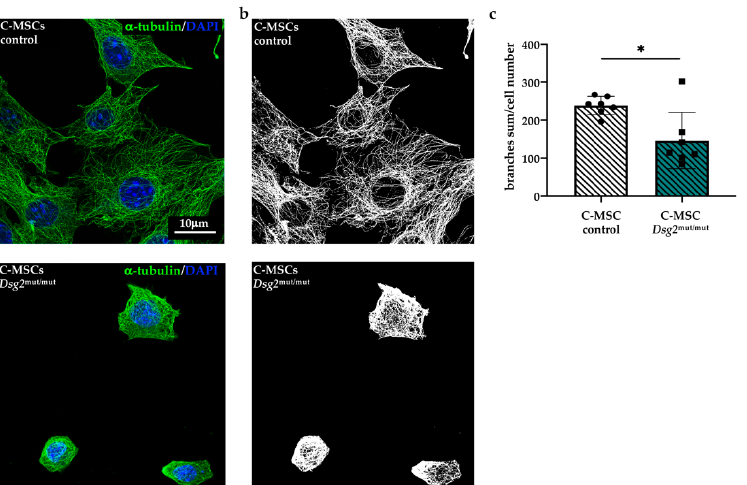
Figure 4. AC-linked Dsg2 variant affects microtubule organization in cardiac mesenchymal stromal cells. ( a ) Super-resolution confocal IF analysis of cultured C-MSCs isolated from control or Dsg2 mut/mut mice. Cells were stained with anti- α -tubulin antibody (green signal). Nuclei were coun- terstained with DAPI (blue signal). ( b ) Skeletonized images shown in ( a ). ( c ) Quantification of total number of microtubule branches/cell in control and AC C-MSCs. A total of 35 cells for each study group were analyzed. Bars represent mean, and error bars represent standard deviation (SD). * p ≤ 0.05.